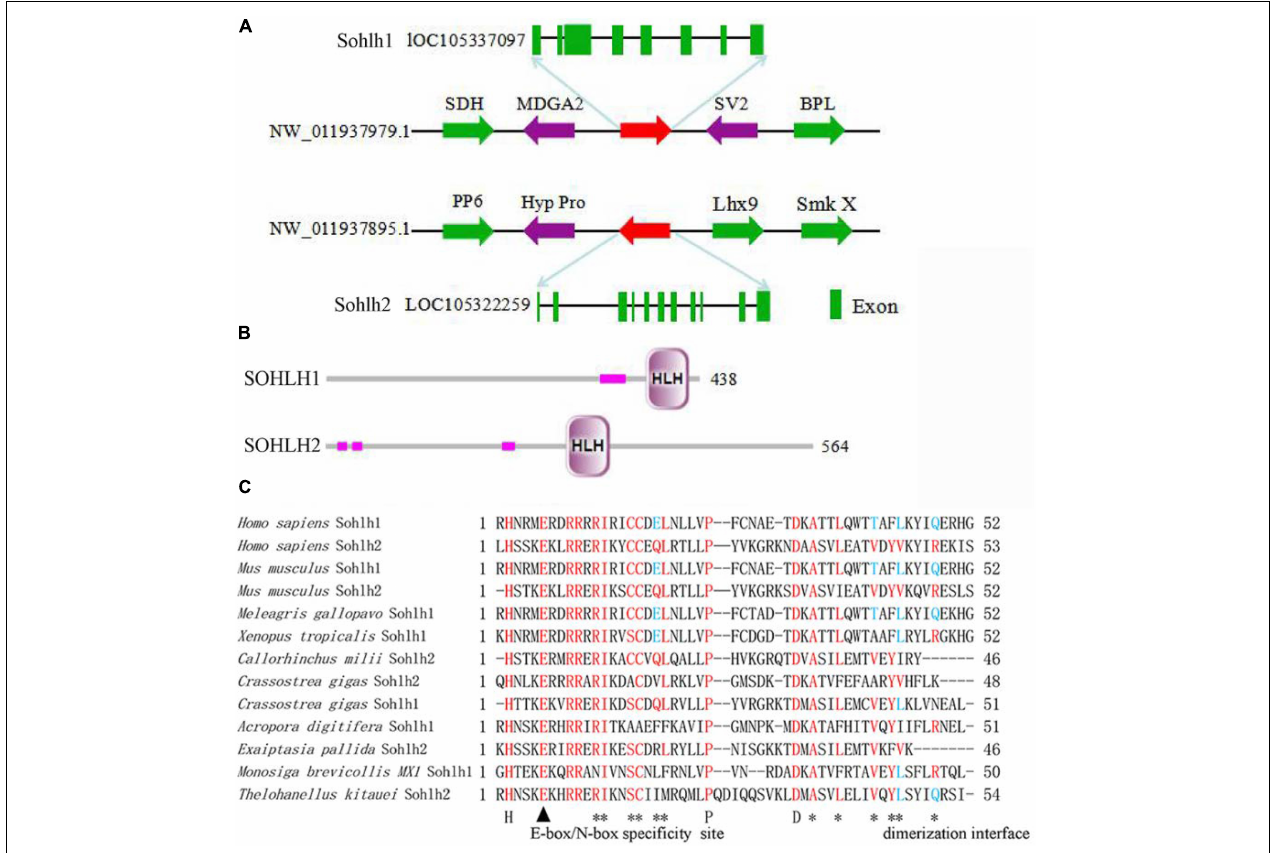
FIGURE 1 | Structural analysis of the Cg-Sohlh genes. (A) The location and exon information of the Cg-Sohlh genes are shown. (B) The structures of the Cg-Sohlh genes are shown; the small pink rectangles represent low complexity regions. (C) The bHLH domain sequence alignment of Sohlh genes in different species is shown; bHLH specificity site: E-box/N-box ( (cid:78) ), dimerization interface ( ∗